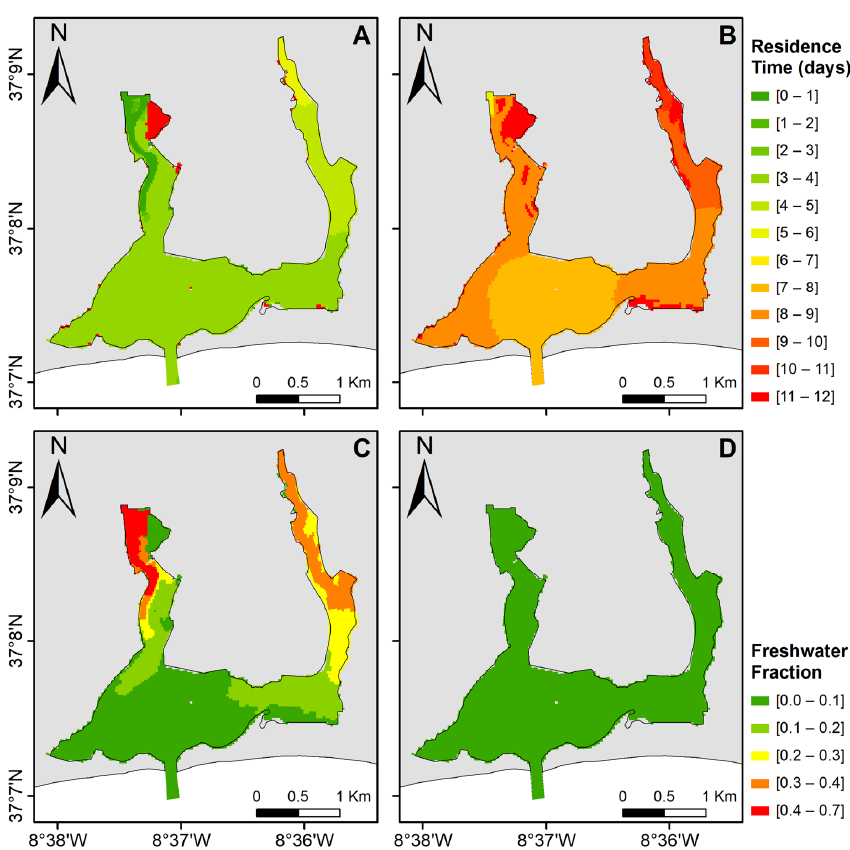
Figure 6. Ria de Alvor residence time (days) and freshwater fraction for winter ( A , C ) and summer ( B , D )